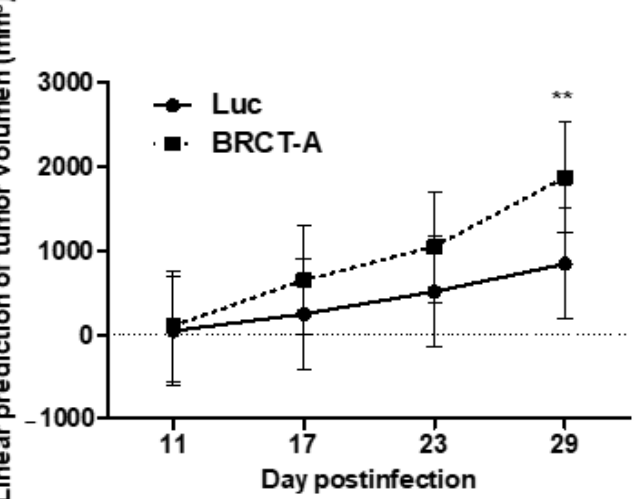
Figure 4. Study of colony formation from mammalian cells expressing the BRCT domain from LmjPES protein. Number of colonies formed after one week of culture of lentiBRCT (BRCT-A and BRCT-B) or lentiLuc (Luc) HEK293T ( A ) and NIH/3T3 ( B ) infected cells. The values represent the mean ±SD of duplicates from three experiments carried out.